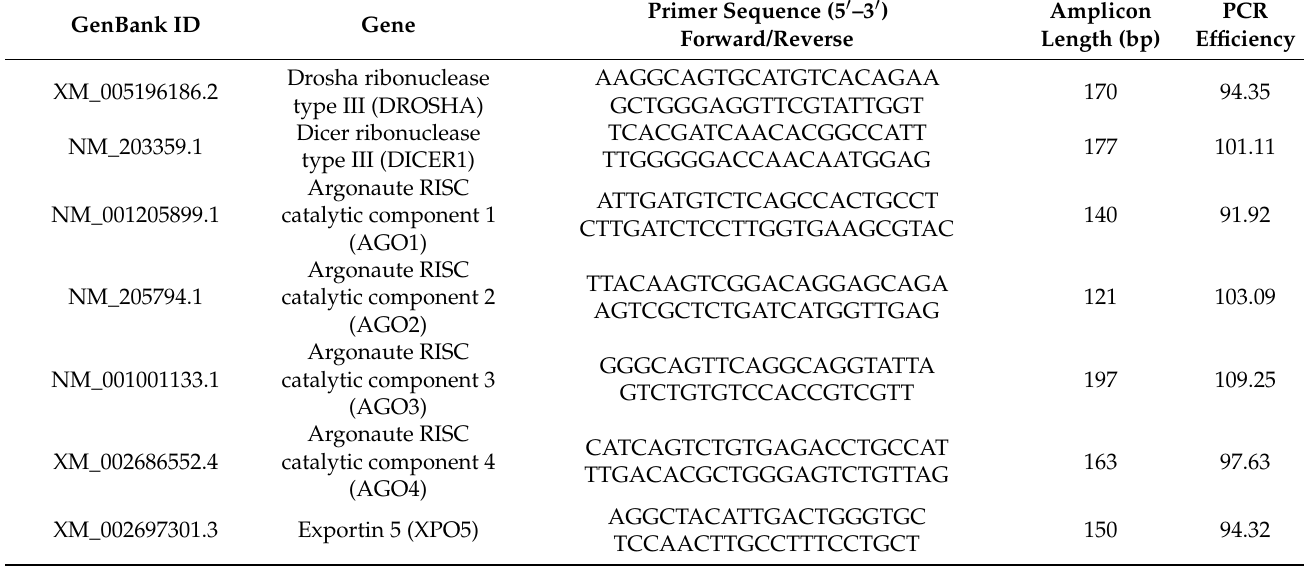
Table 3. Primer sequences and amplicon characteristics of transcripts from members of the miRNA processing machinery. GenBank